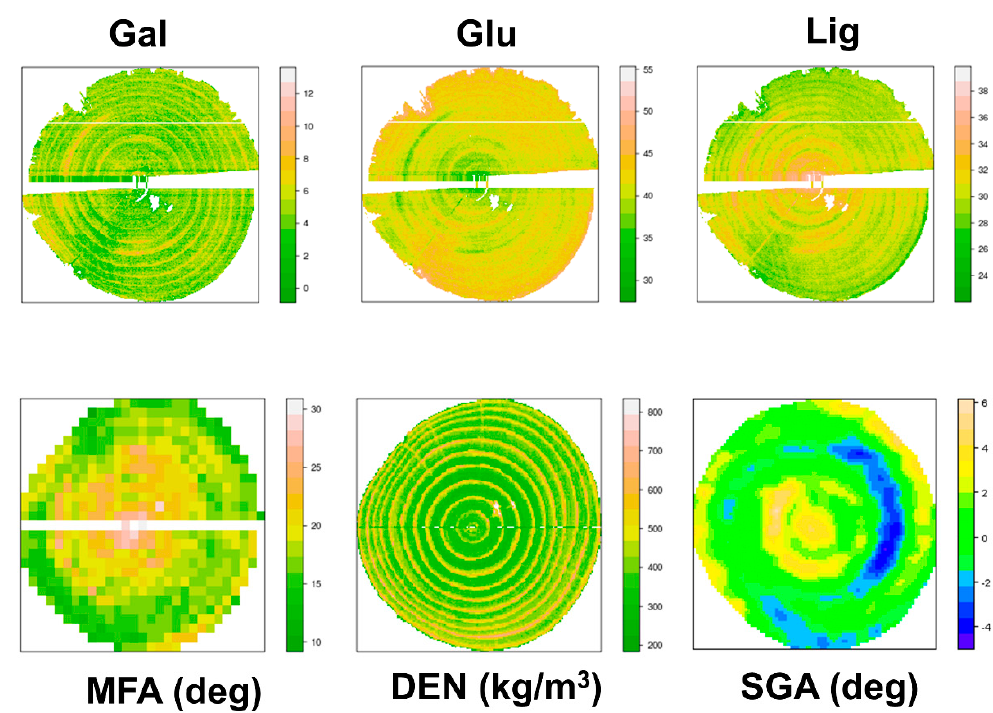
Figure 16. Examples of wood property maps produced by the DiscBot for galactan content (Gal), glucose content (Glu), lignin content (Lig), microfibril angle (MFA), density (DEN), and grain angle (SGA).